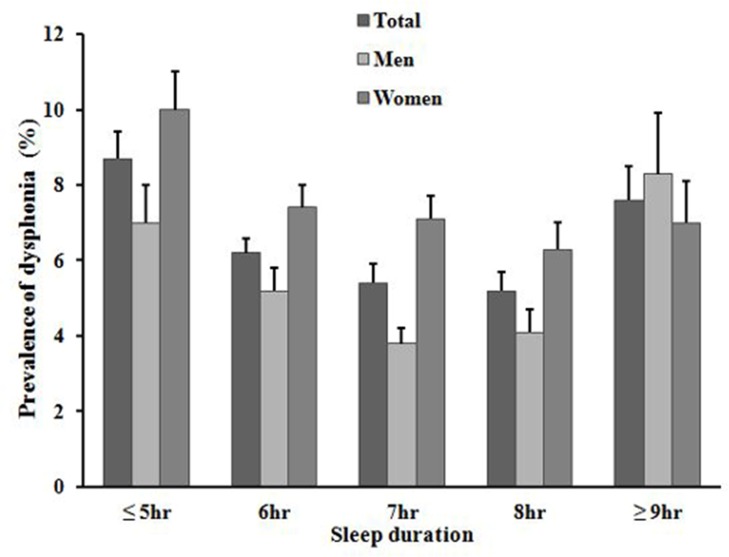
The prevalence of dysphonia by sleep duration.